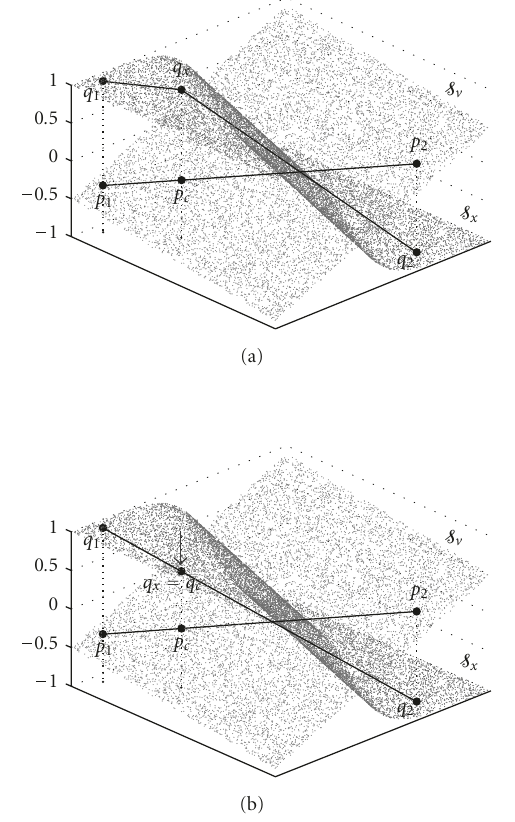
Figure 7: Example of a companion pair C p . (a) In a 3D space, 1 , q 1 p 1 and q 1 have the same values on the coordinates s 1 and s 2 . (b) In time series plots, p 1 and q 1 are at the same time